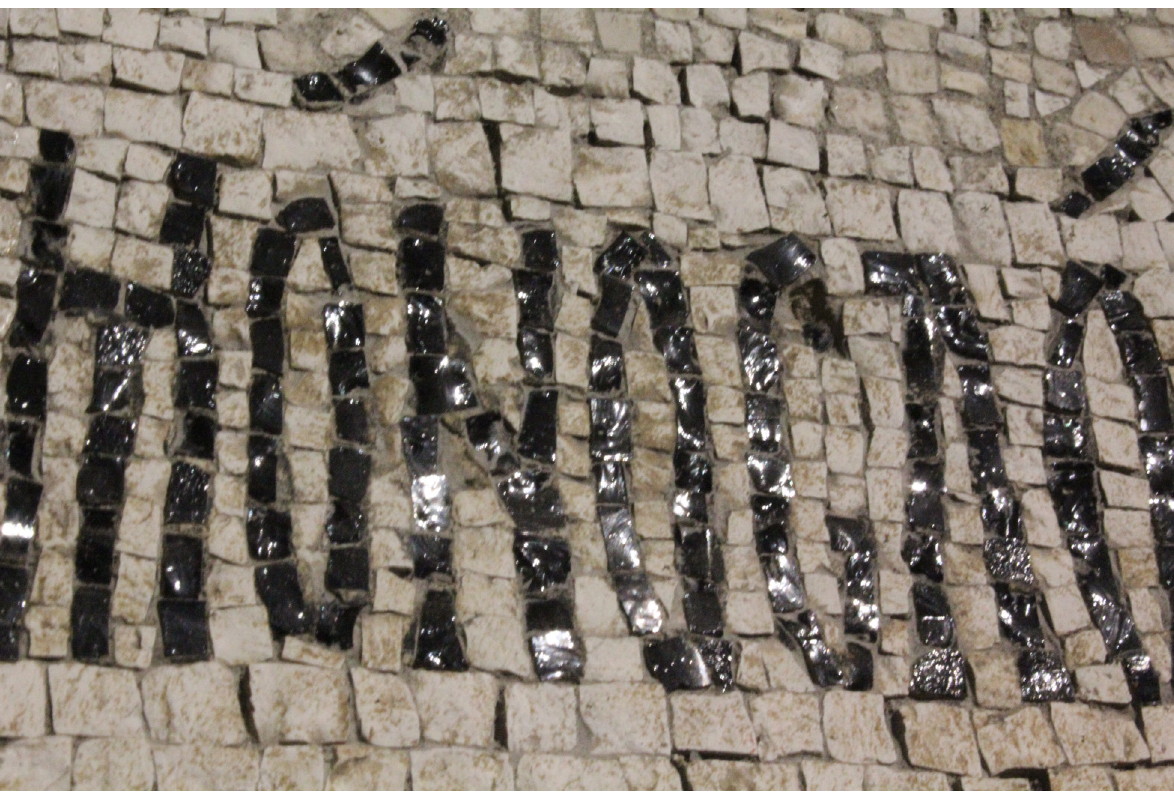
Figure 4: Palermo, St. Mary of the Admiral, Dedication panel, detail of the text in the white sheet, characters in black glittering tesserae (photo V.